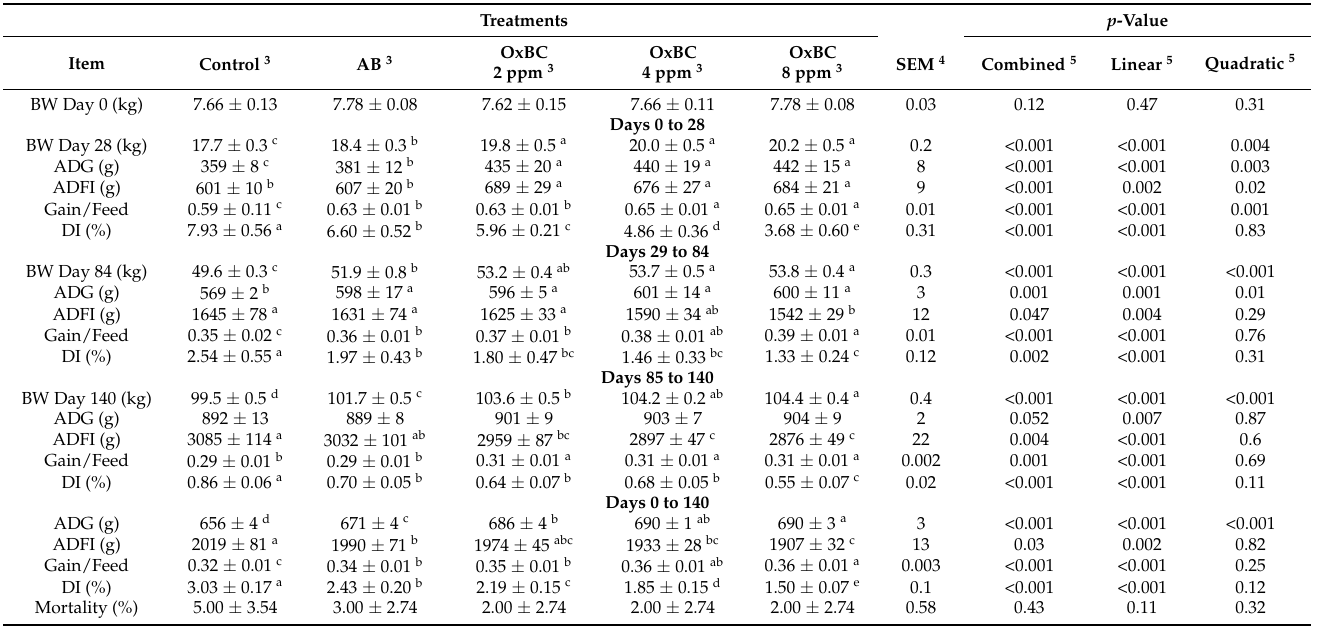
Table 2. Effect of oxidized β -carotene (OxBC) on growth performance of pigs from post-weaning to finish 1,2